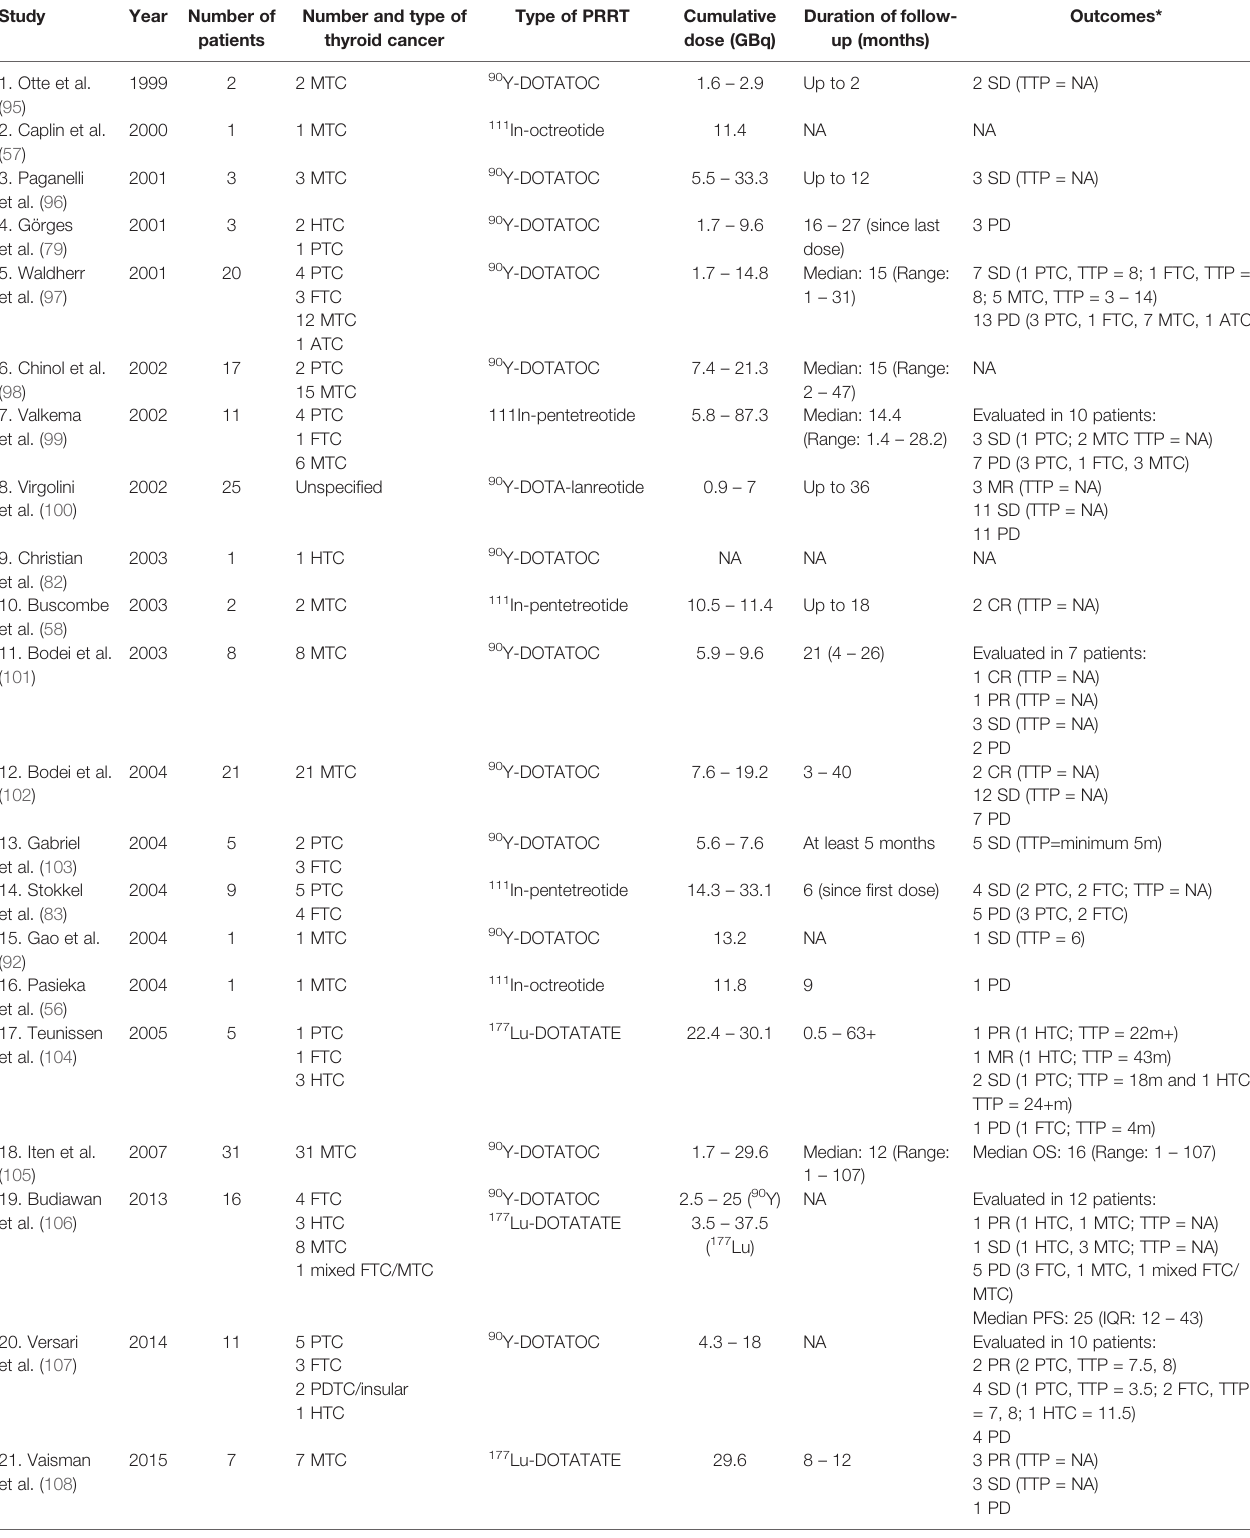
TABLE 1 | List of studies evaluating the ef fi cacy of PRRT in thyroid